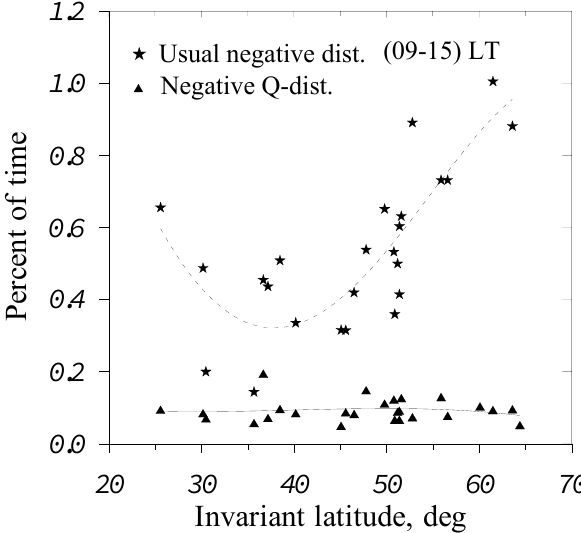
Fig. 2. Fig. 2. Latitudinal variations of the percent of time occupied by the usual and Q-disturbances in the daytime LT sector. A polynomial approximation of the variations is given for the sake of obviousness. Note very small latitudinal changes for the